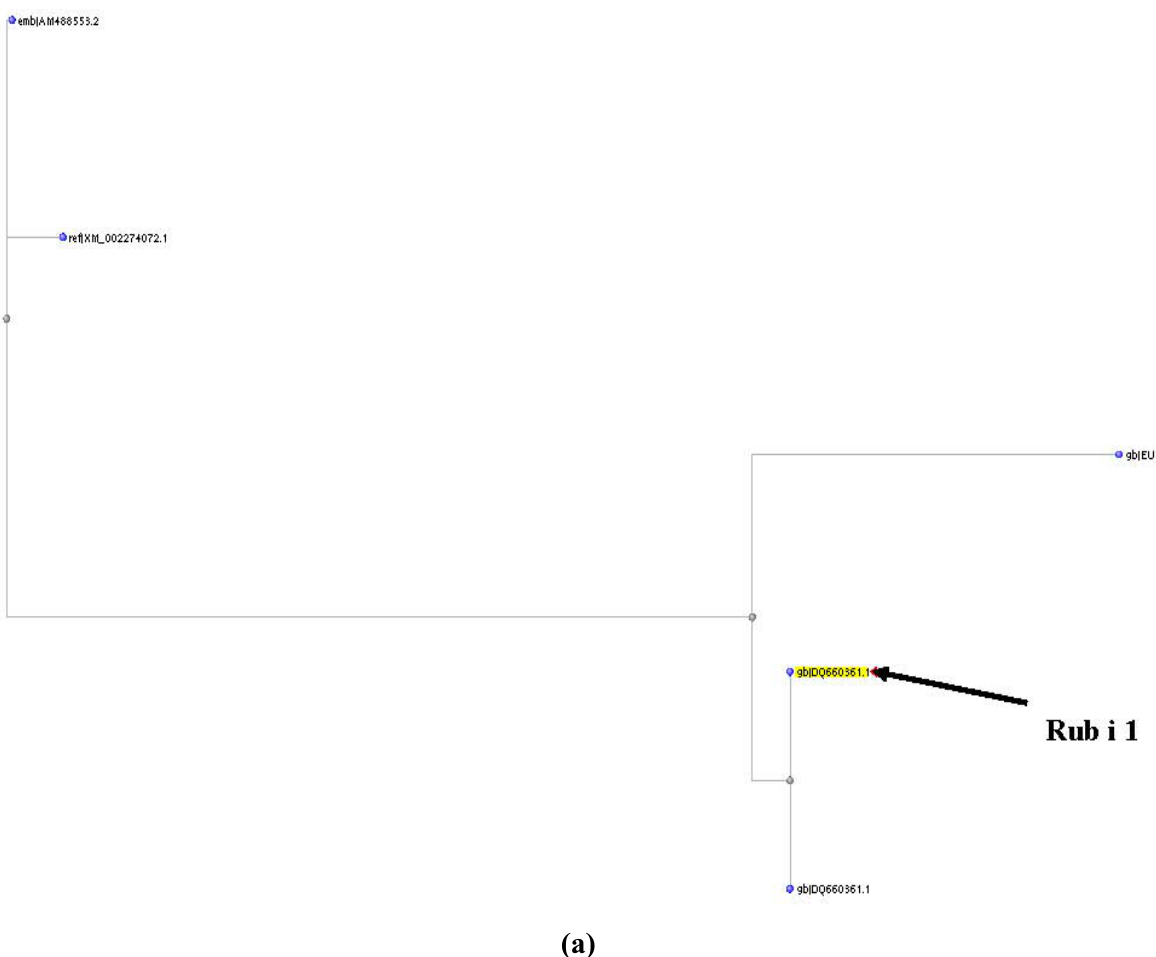
Figure Ι . A BLAST pairwise alignment based on genomic sequences between a) Rub i 1; b) Rub i 3 and the NCBI database (GenBank accession